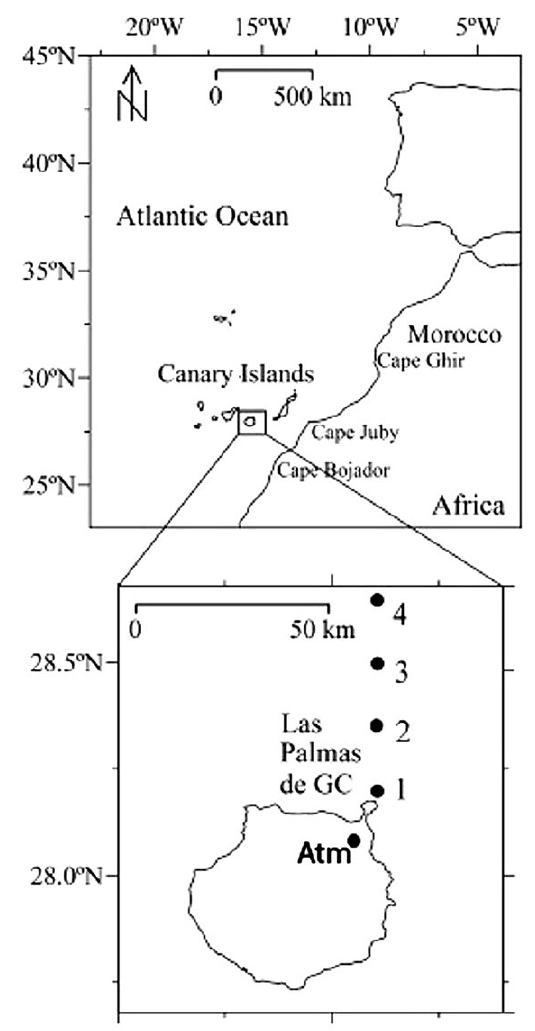
Fig. 1. – Location of the study area. Oceanographic stations (dots 1-4) and atmospheric station (Atm) at 300 m above sea